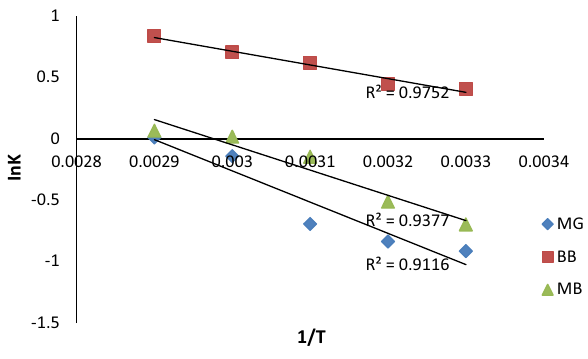
Fig. 11 van’t Hoff graph for Zn(II) adsorption at different temperature